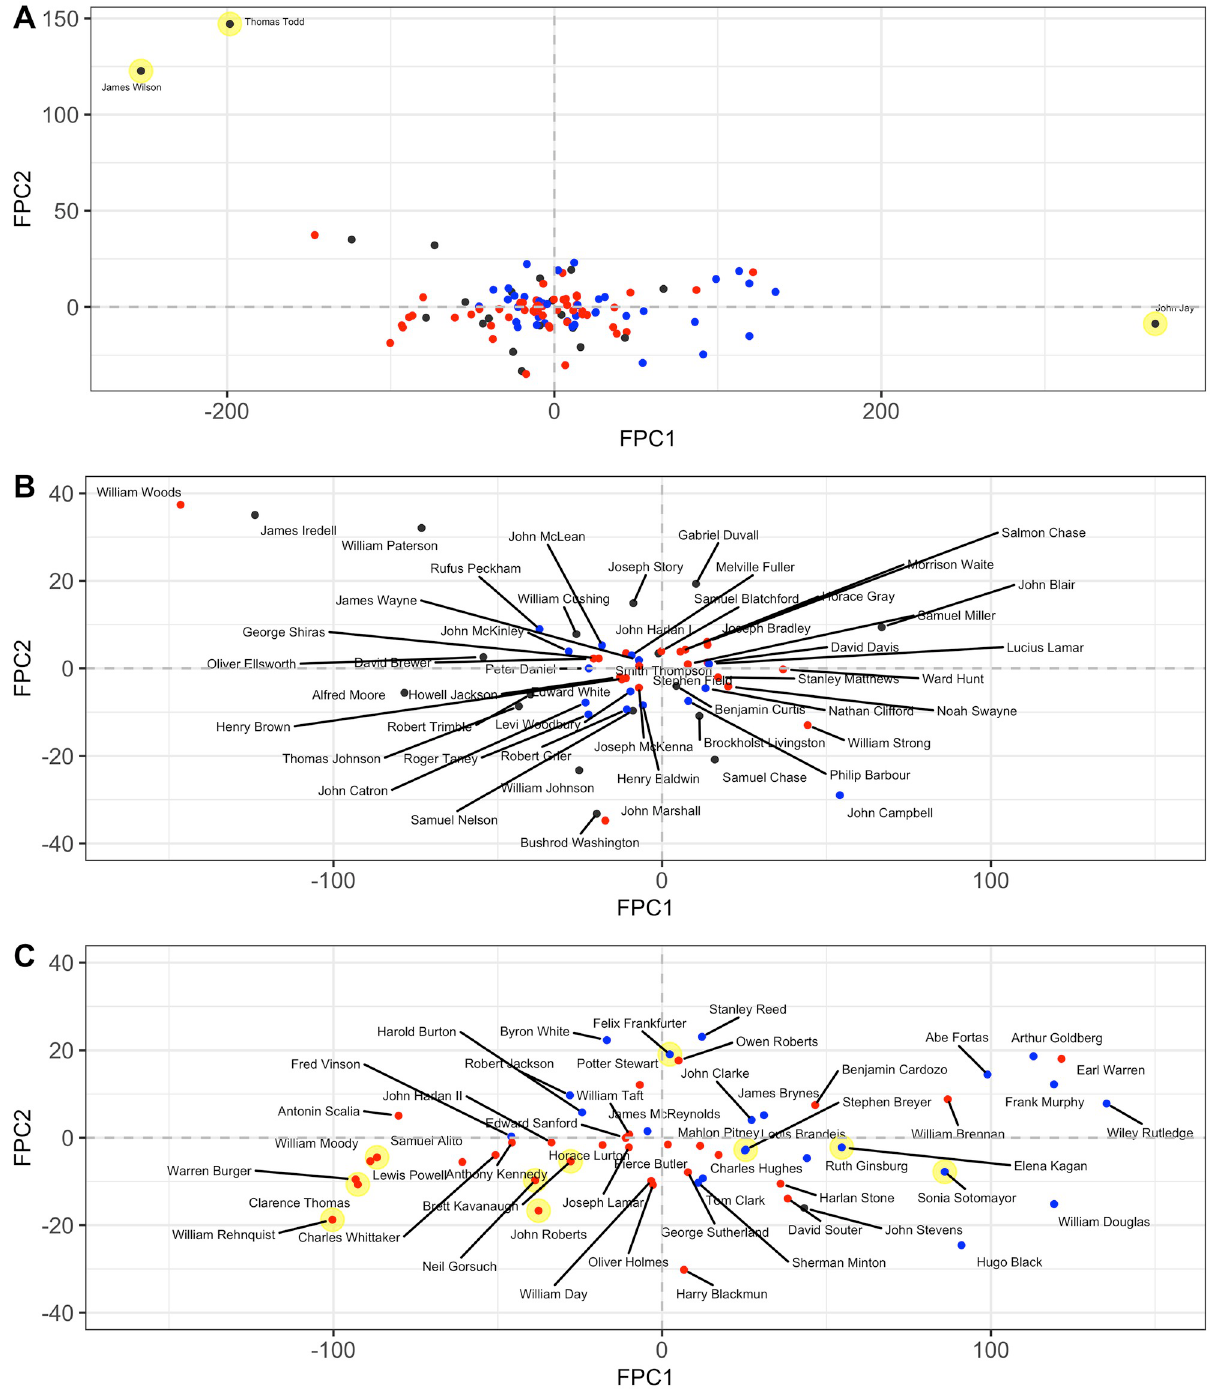
Fig 4. First and second Functional Principal Components (FPCs). Estimated FPCs were obtained as per Eq (6). They visualize the FPC-space representation of ideology trajectories, where coordinates represent the amount of deviation from the average trajectory in the direction of the first and second eigenfunctions. Color coded by the nominating president’s party (blue for Democratic, red for Republican). The justices that are mentioned specifically are highlighted in yellow. (A) exhibits all 113 justices, with 3 obvious outliers: Thomas Todd, James Wilson, and John Jay. (B) exhibits all non-outlier justices before 1900 with annotated names. (C) exhibits all non-outlier justices after 1900 with annotated names.